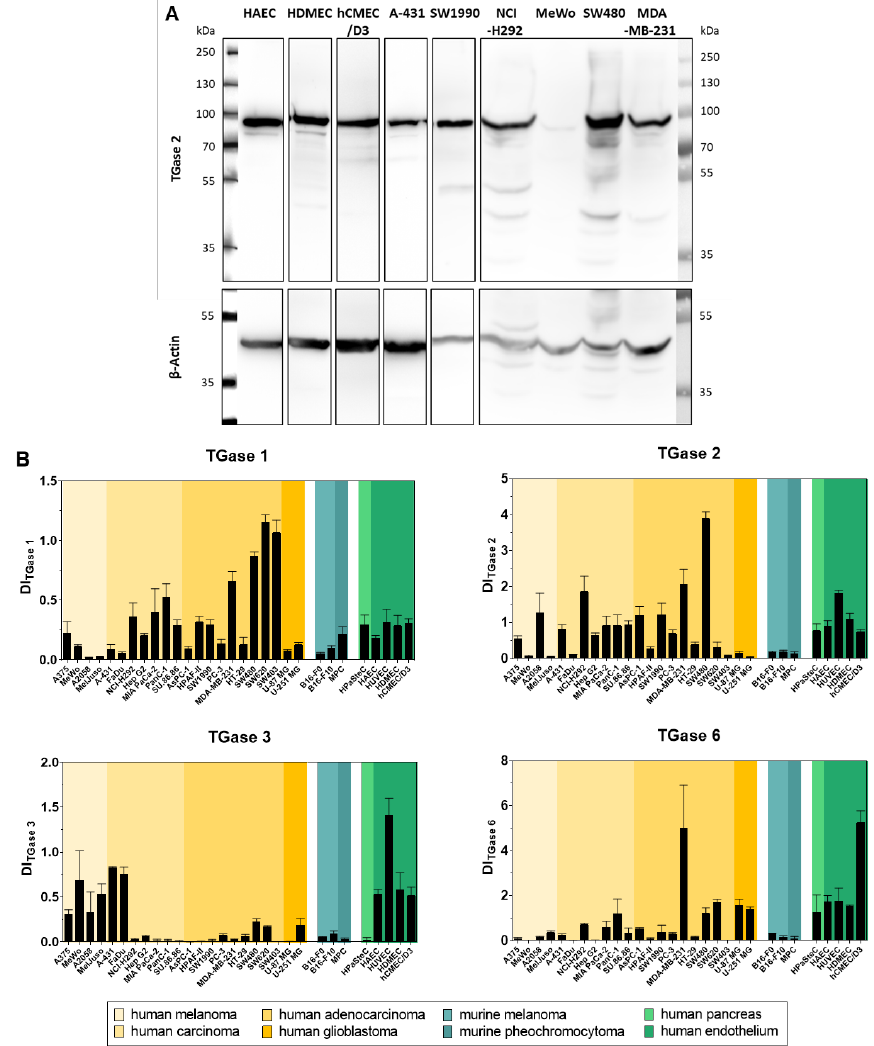
Figure 7. Synthesis of TGase 1, TGase 2, TGase 3, and TGase 6 in different human and mouse cancer cell lines and human noncancer cell lines. ( A ) Exemplary Western blot lanes for selected cell lines which show additional bands of apparent lower molar mass than the full length TGase 2. Thermo Scientific™ PageRuler™ Plus Prestained Protein Ladder was acquired with white light illumination and automatically merged to the chemiluminescent image (imager Celvin S). ( B ) Relative expression of TGases in different cell lines was investigated by Western blotting. Analysis of the blots was per- formed via densitometry and data were related to β - actin as loading control. n ≥ 3, mean ± SEM. Cell lines were sorted by tumor type and indicated by different colors: human melanoma, carci- noma, adenocarcinoma, glioblastoma (highlighted in yellow), and mouse melanoma and pheochro- mocytoma origin (highlighted in cyan), as well as human pancreatic and endothelial cell lines (high- lighted in green). Densitometric indices, D I , were calculated using Equation (4) (Section 4.6.). For TGase 2, the relative expression data in Figure 7B were correlated with the con- centration values derived from the FA-based assay (Figure 8). Basically, the higher the relative expression of TGase 2, the higher the measured TGase 2 activity, even though the correlation is only moderate (r = 0.55). For most of the cell lines, a single band